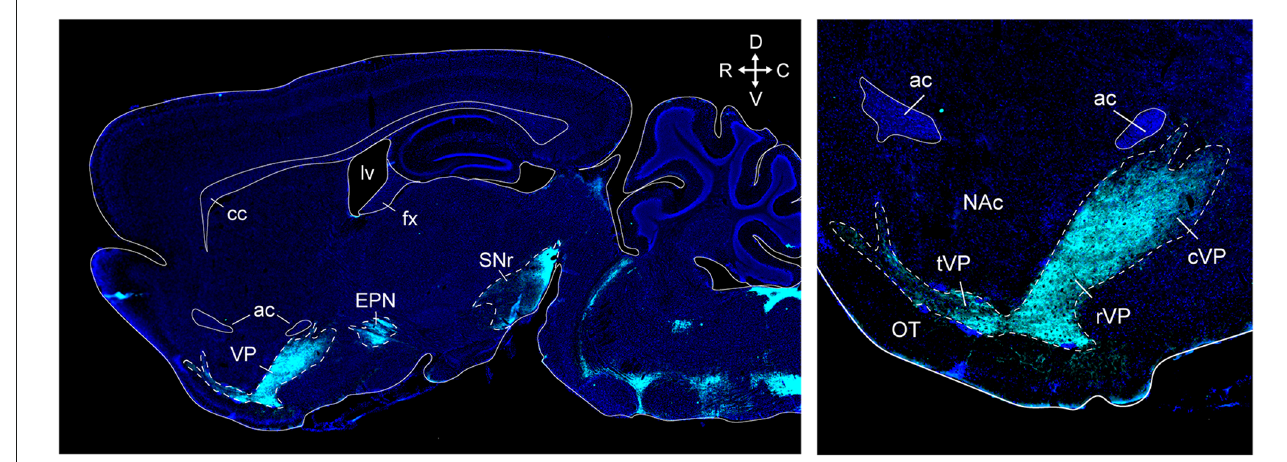
FIGURE3 VP and other basal ganglia structures in a sagittal section of the mouse brain. Supstance P immunostaining (cyan) clearly outlines the VP, endopeduncular nucleus, and substantia nigra (top left). Distinct ventral pallidum subregions along the rostrocaudal axis can be seen at higher magnification in this section (top right). The tubercular rostral VP introdes the olfactory tubercle as “fingerlike extensions”. The rostral VP is located ventral to the NAc, and the caudal VP is located posterior to the NAc and ventral to the anterior commissure. ac, anterior commissure; cc, corpus callosum; fx, fornix; lv, lateral ventricle; cVP, caudal ventral pallidum; rVP, rostral ventral pallidum; tVP, tubercular ventral pallidum; OT, olfactory tubercle; NAc, nucleus accumbens; EPN, endopeduncular nucleus; SNr, substantia nigra pars reticulata. Arrows indicate the orientation of the brain along the rostrocaudal (RC) and mediolateral (ML) axes. Sections are counterstained with DAPI (blue). Figure adopted from Zahm et al. (1996) and Heinsbroek et al.